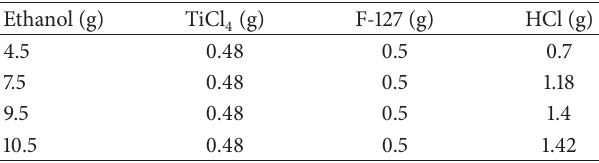
Table 1: Different concentrations of sol-gel preparation for thick- ness